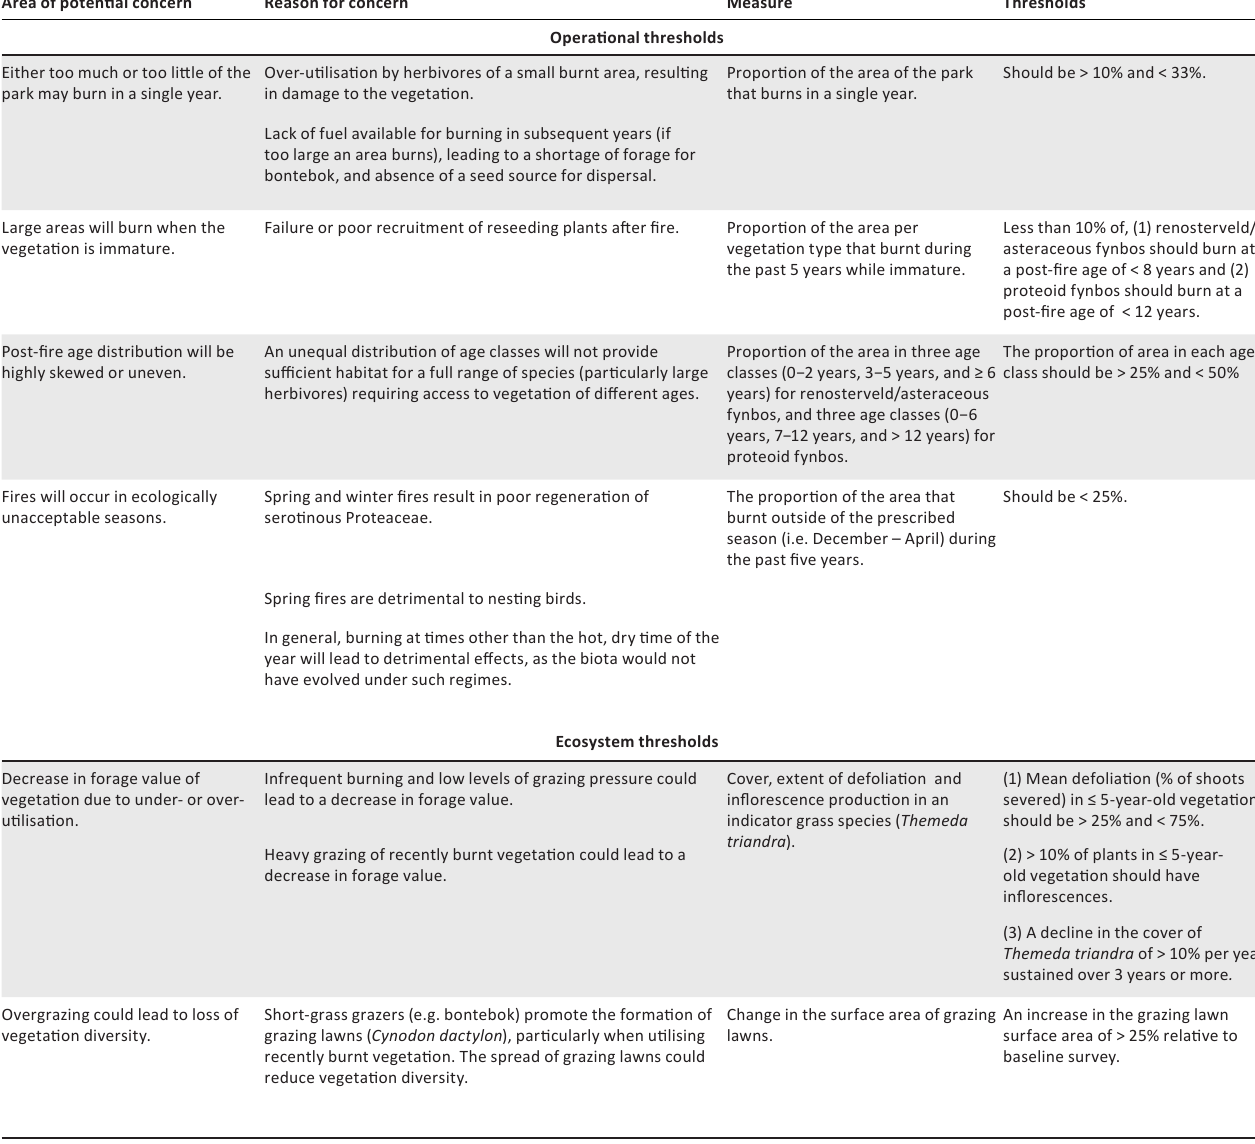
TABLE 3: Proposed thresholds of potential concern relating to fire management and fire-herbivory interactions in the Bontebok National Park. Area of potential